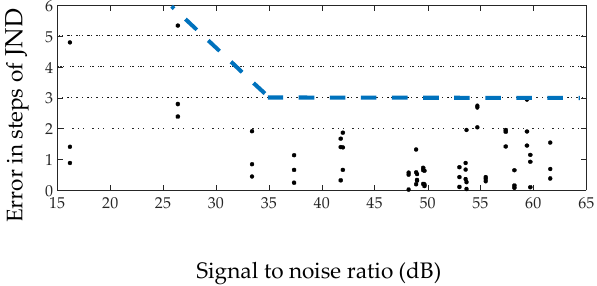
Figure 13. T 20 parameter value errors measured with a handclap (compared to measurements with a dodecahedron) in steps of Just Noticeable Difference (JND) as a function of the signal-to-noise ratio for different octave bands. The dashed line represents a threshold below which all JND values were measured.